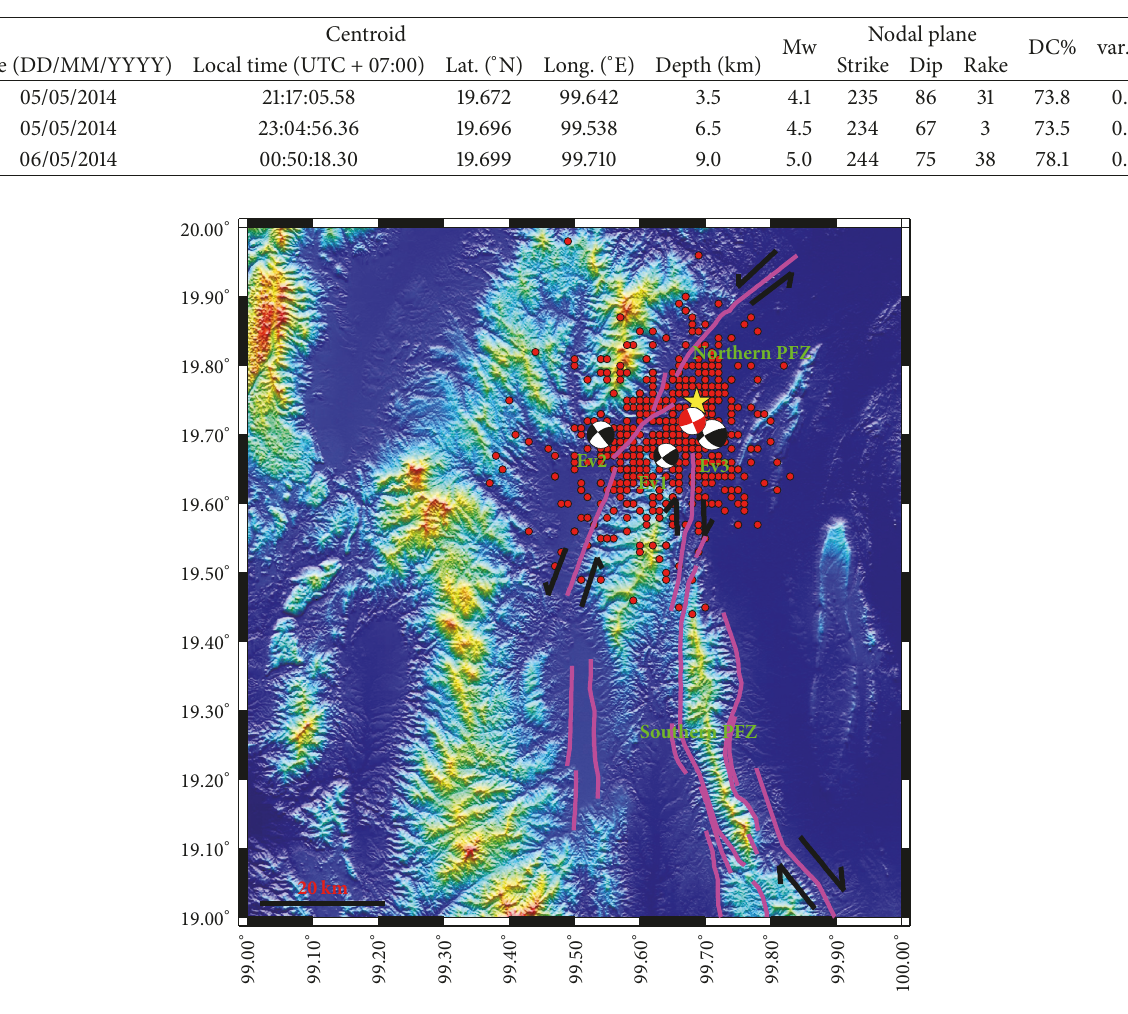
Figure 2: A yellow star and red dots are Mw 6.3 epicentre and aftershocks (05 May 2014–05 June 2014) reported by TMD, respectively. Fault- plane solutions of selected events calculated by the DMT inversion represented in black beach balls. A red beach ball indicates the focal mechanism of the main shock given by global CMT project. The pink solid lines are fault lines from the Phayao Fault Map [4]. Ev = event related, Table